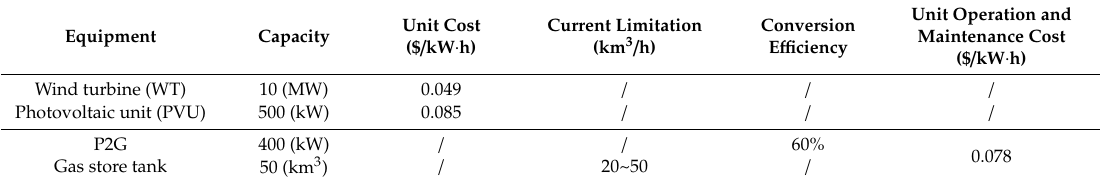
Table 2. Equipment parameters of the wind turbine (WT), the photovoltaic unit (PVU), and the P2G and gas storage tank (PGST).